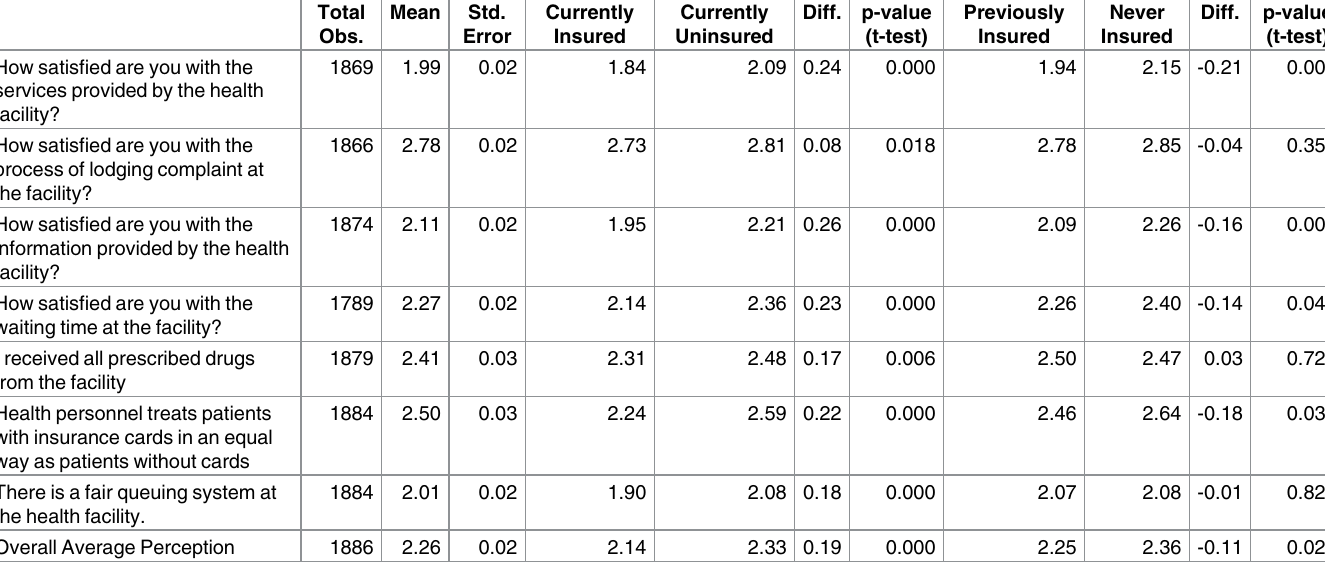
Table 2. Differencesbetween the insured and uninsured in the averageperception of quality of 64 health facilities. Total